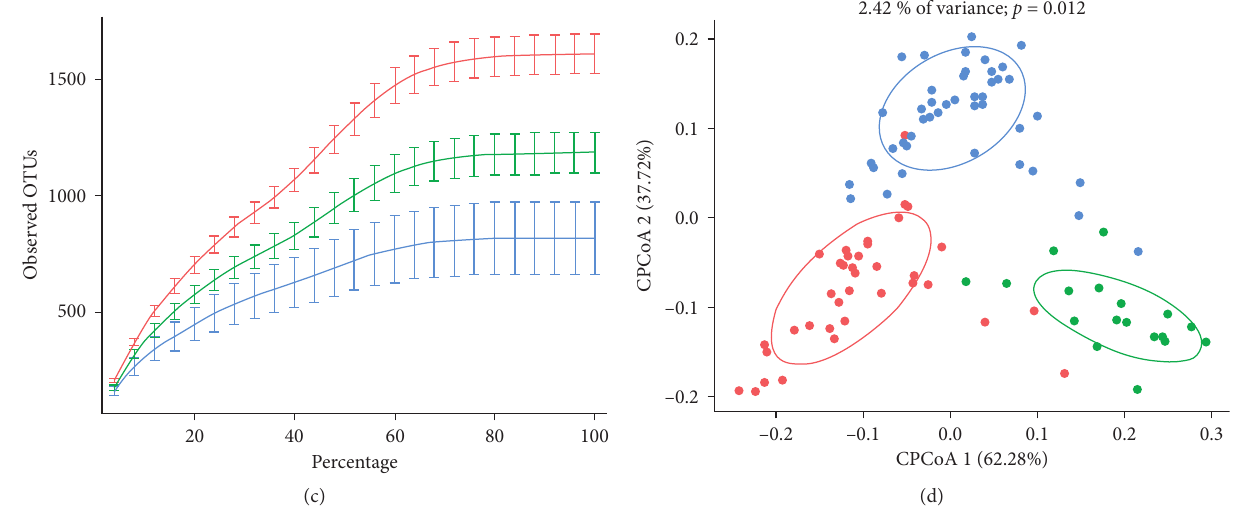
Figure 1: The gut microbiota composition in healthy controls and HT patients with euthyroidism and hypothyroidism. Alpha diversity, including Richness index (a) and Shannon index (b). Rarefaction curves (c) and constrained principal coordinate analysis (CPCoA) (d) according to weighted Unifrac distances were carried out to assess beta diversity among controls (denoted as red circles), HTwith euthyroid HT patients (green circles), and hypothyroidism (circles in blue). Ellipses correspond to the clustering of fecal samples for each group encircling 95% confidence interval. CON, healthy controls; HTN, patients bearing Hashimoto’s thyroiditis with euthyroidism; HTH, HT patients with